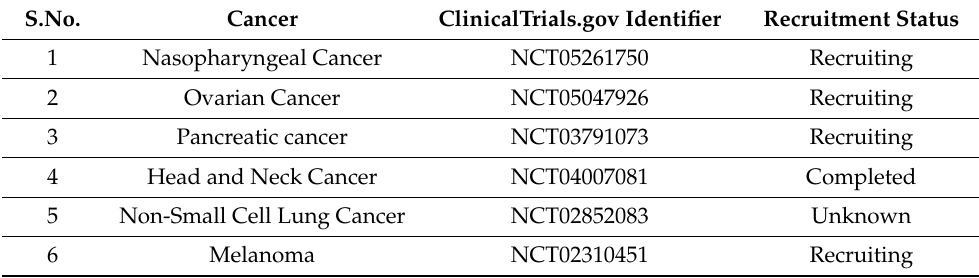
Table 2. Clinical studies investigating safety and potential of secretome in cancers. S.No. Cancer ClinicalTrials.gov